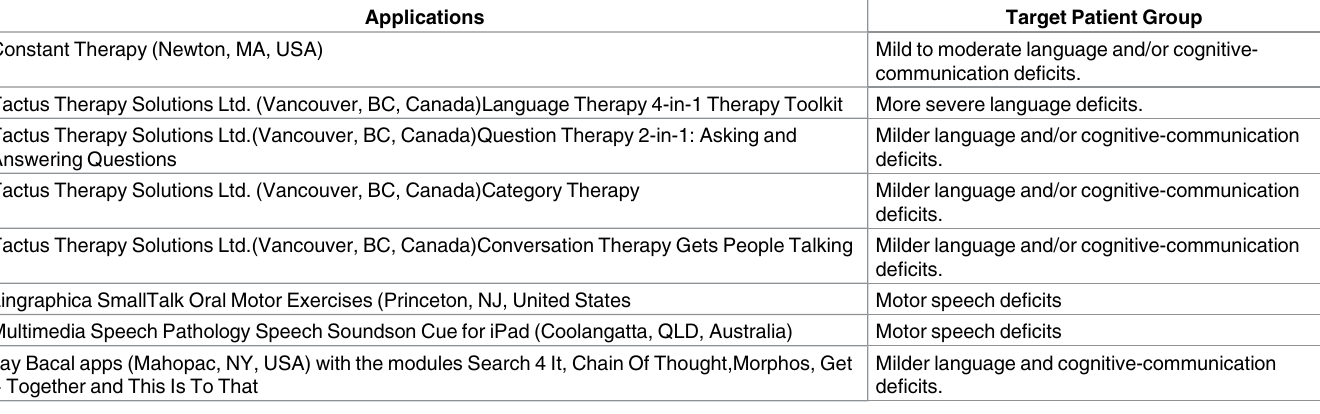
Table 1. Commercially available applications and their use.